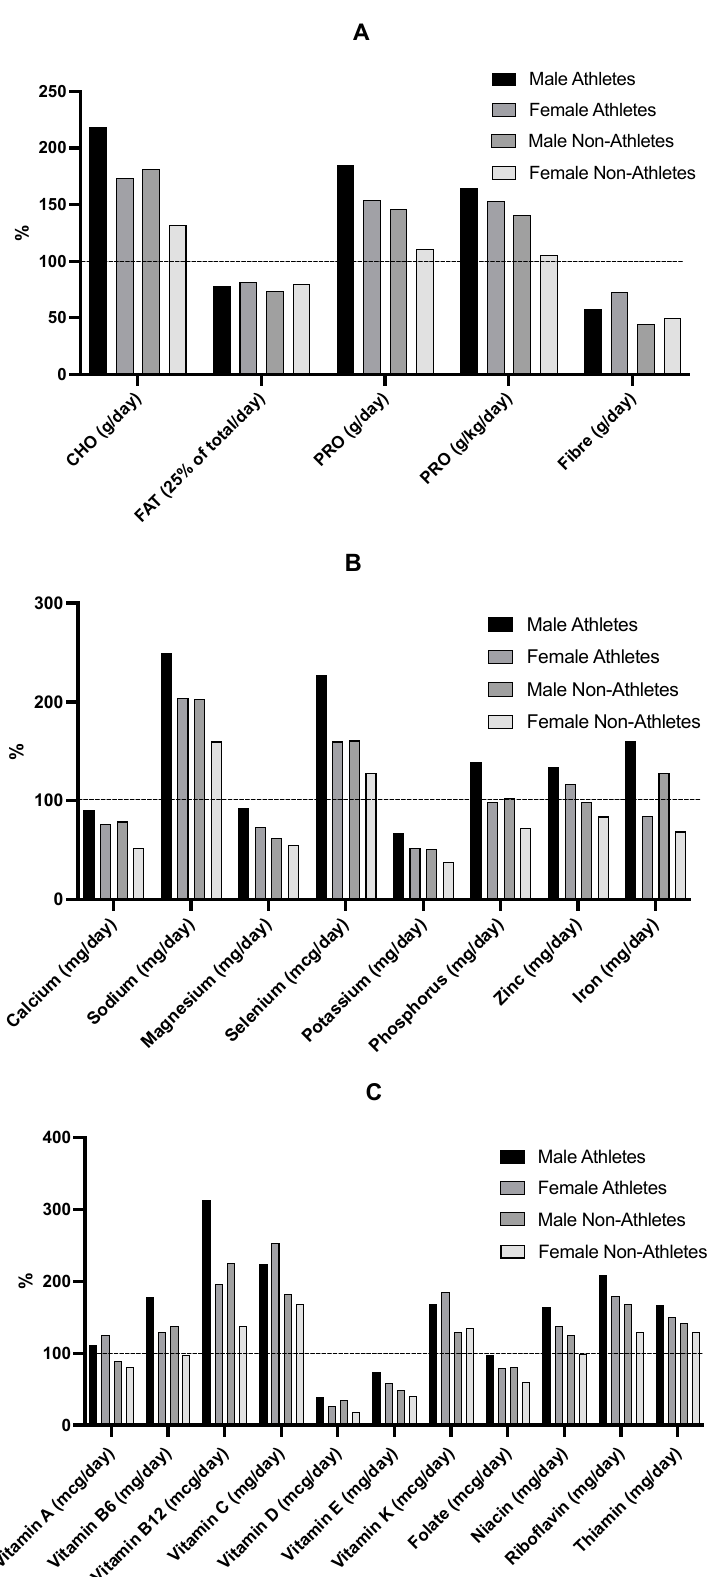
Figure 3. Adequacy of the dietary intake of macronutrients ( A ), micronutrients ( B ), and vitamins ( C ) as percentages of the Canadian recommended dietary intakes (RDI) for adolescent females and males (14–18 years of age). When RDI could not be applied, adequate intake (AI) was used instead. ( n = 116).